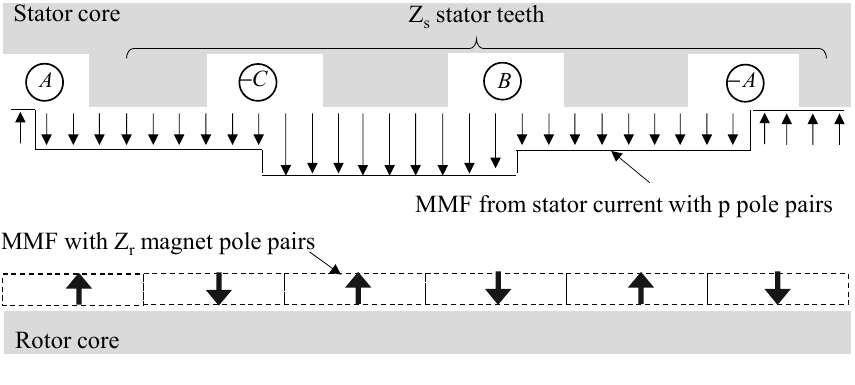
Figure 1. The structure of a PM machine.